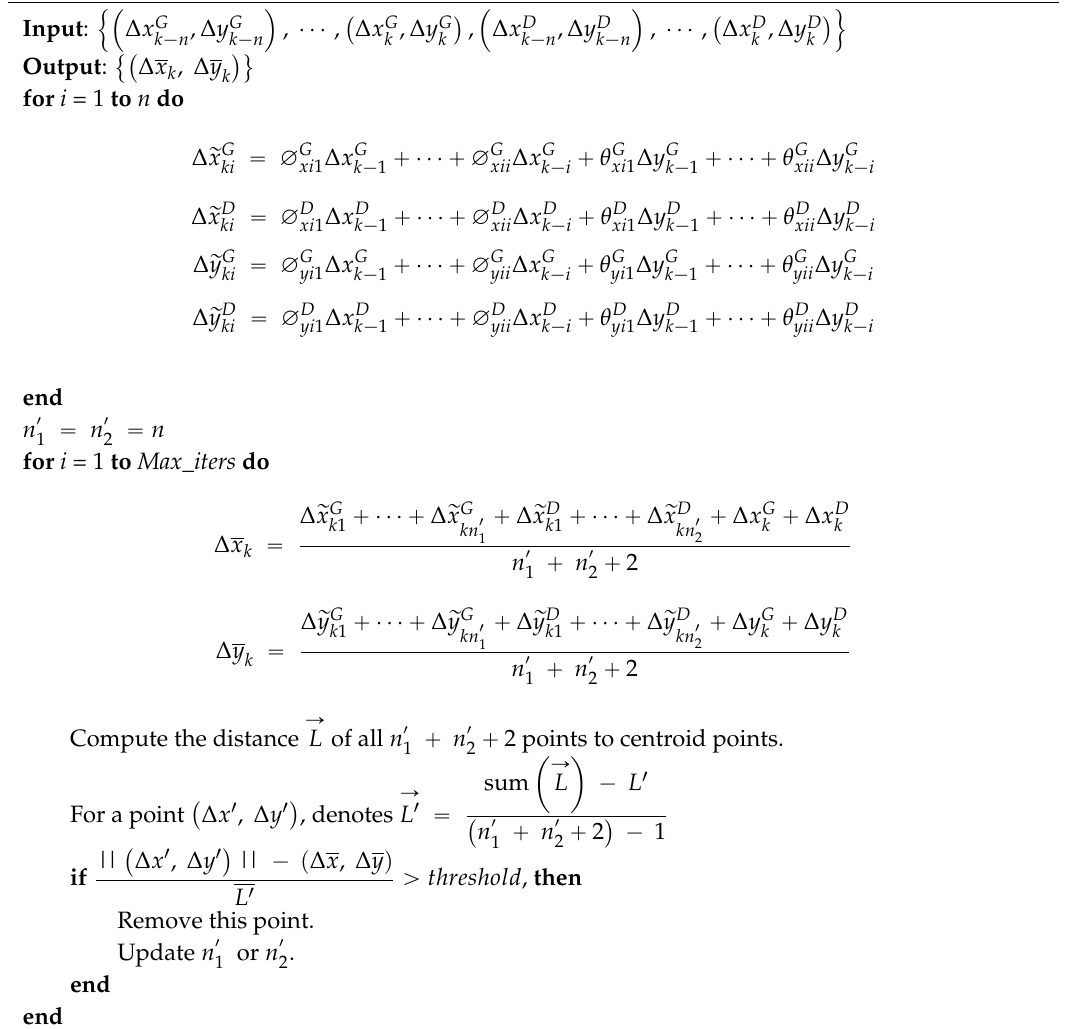
Algorithm 1. Spatial Consensus